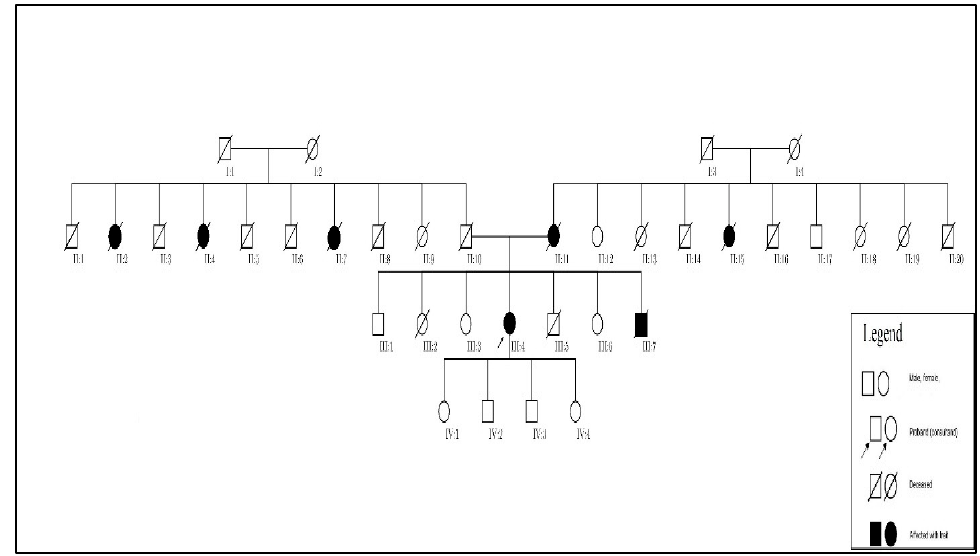
Figure 4. Family pedigree of aneurysmal and dissection disease. Affected members are shaded in black, indicating presumed aneurysmal or dissection disease based on patient provided history.